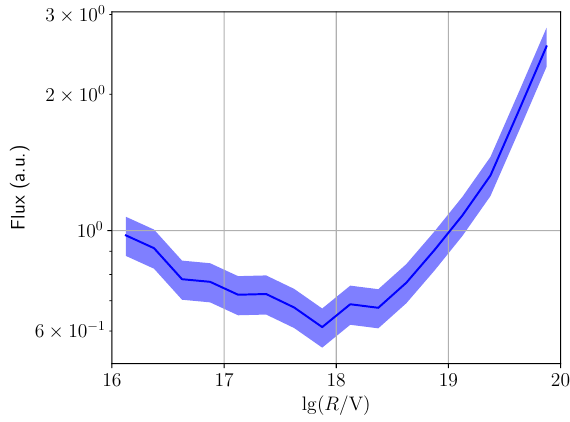
Figure 3: Modification of the rigidity spectrum of GCRs imposed by the GMF. Figure 4: Modification of the rigidity spectrum of EGCRs